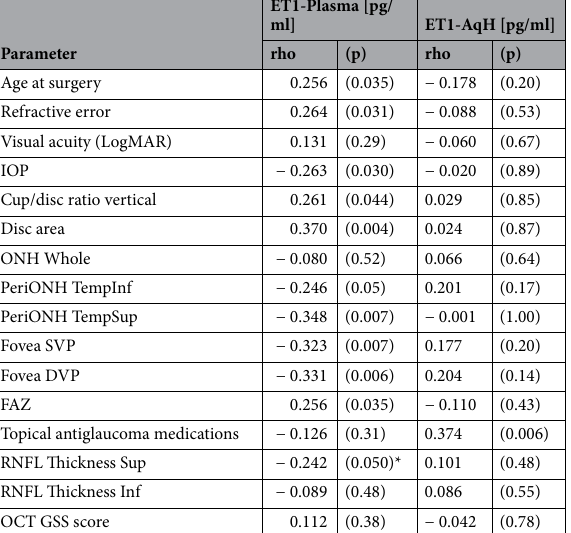
Table 2. Correlation of ET-1 level in plasma or AqH to OCT/OCT-A parameters in glaucoma. The p-value p = 0.050* in the table indicates the significance of the corresponding test, that means p < 0.05. a Correlation coefficient: Pearson’s rho for bivariate gaussian distributions, otherwise Spearman’s rho. b Correlation test: Pearson’s method for bivariate gaussian distributions, otherwise Spearman’s